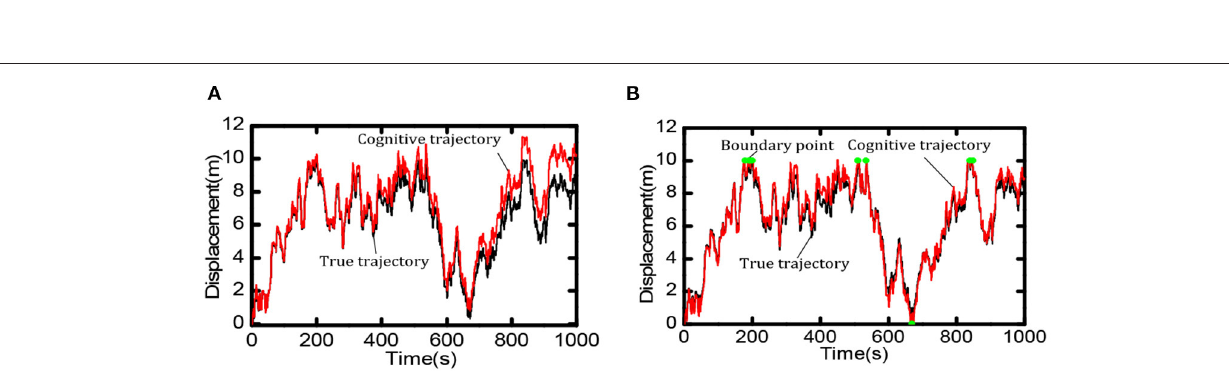
FIGURE 12 | Pattern movement of grid firing. The red circle represents the peak firing period of a single grid cell, and the blue represents the low firing period.